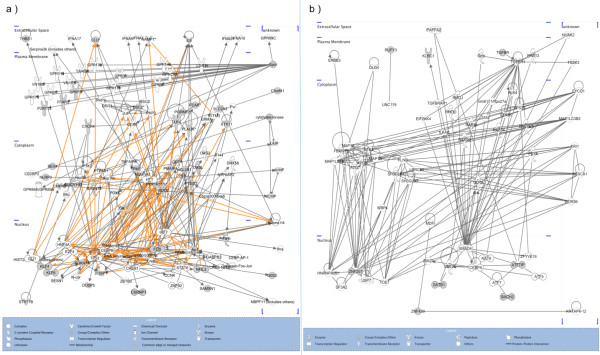
Functional networks inferred using IPA. a) Merged view of functional network derived from upregulated genes using IPA (Network 1: Cell Death, Renal Necrosis/Cell Death, Cancer; Network 2: Cardiovascular Disease, Hematological Disease, Infection Mechanism; Network 3: Inflammatory Response, Embryonic Development, Cell-To-Cell Signaling and Interaction Network 4: Neurological Disease, RNA Post-Transcriptional Modification; Network 5: Cardiovascular Disease, Genetic Disorder, Cellular Function and Maintenance; Network 6: Drug Metabolism, Nucleic Acid Metabolism, Small Molecular Biochemistry). b) Functional networks derived from downregulated genes using IPA (Network 1: Cellular Development, Cellular Assembly and Organization, Cell Cycle; Network 2: Genetic Disorder, Ophthalmic Disease, Nervous System Development and Function; Network 3: Embryonic Development, Gene Expression, Protein Trafficking Network 4: Cellular Assembly and Organization, Cell Morphology, Cellular Function and Maintenance).